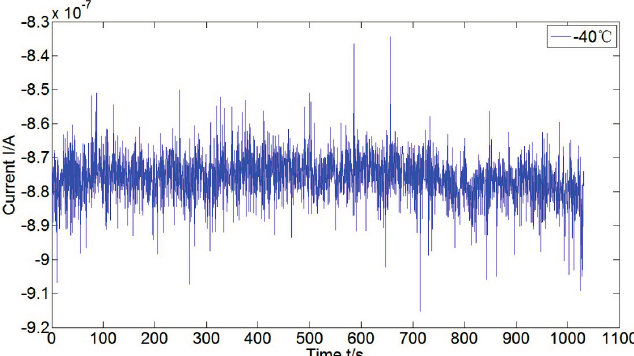
Figure 7. Current bias of the accelerometer at different temperatures.